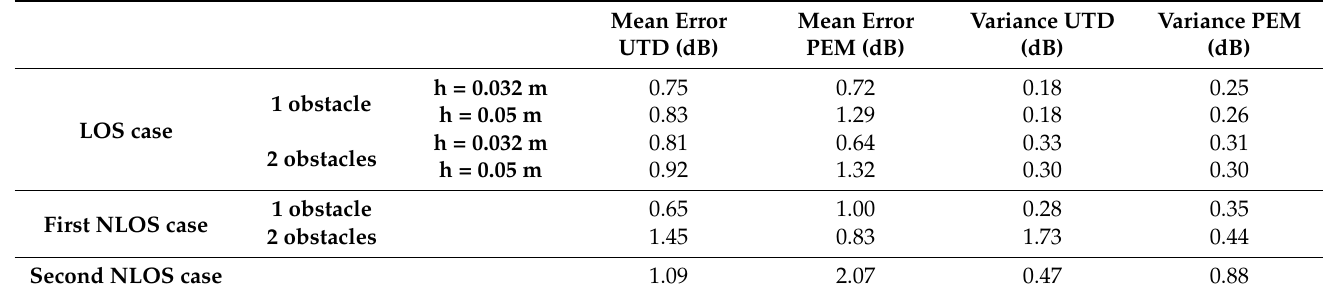
Table 1. Mean error and variance between the theoretical and experimental results presented in the previous